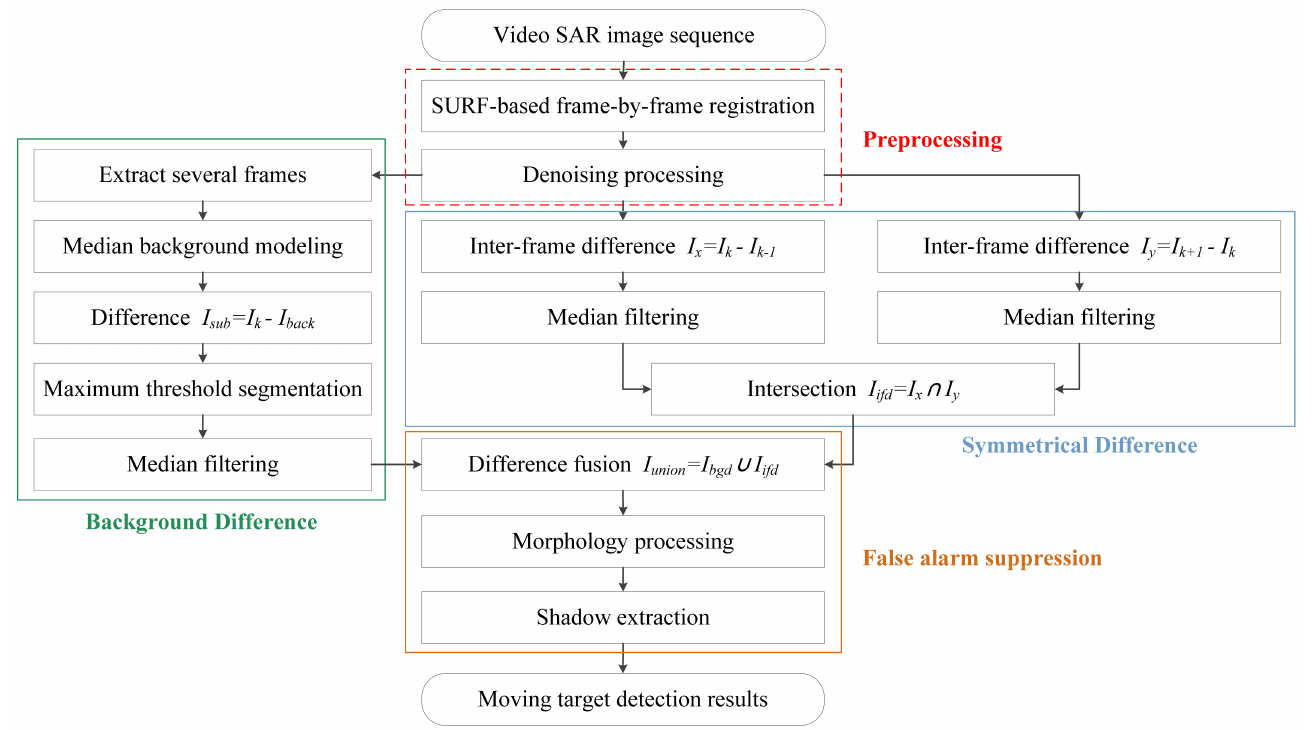
Figure 13. Flowchart of the shadow-based ground moving target detection